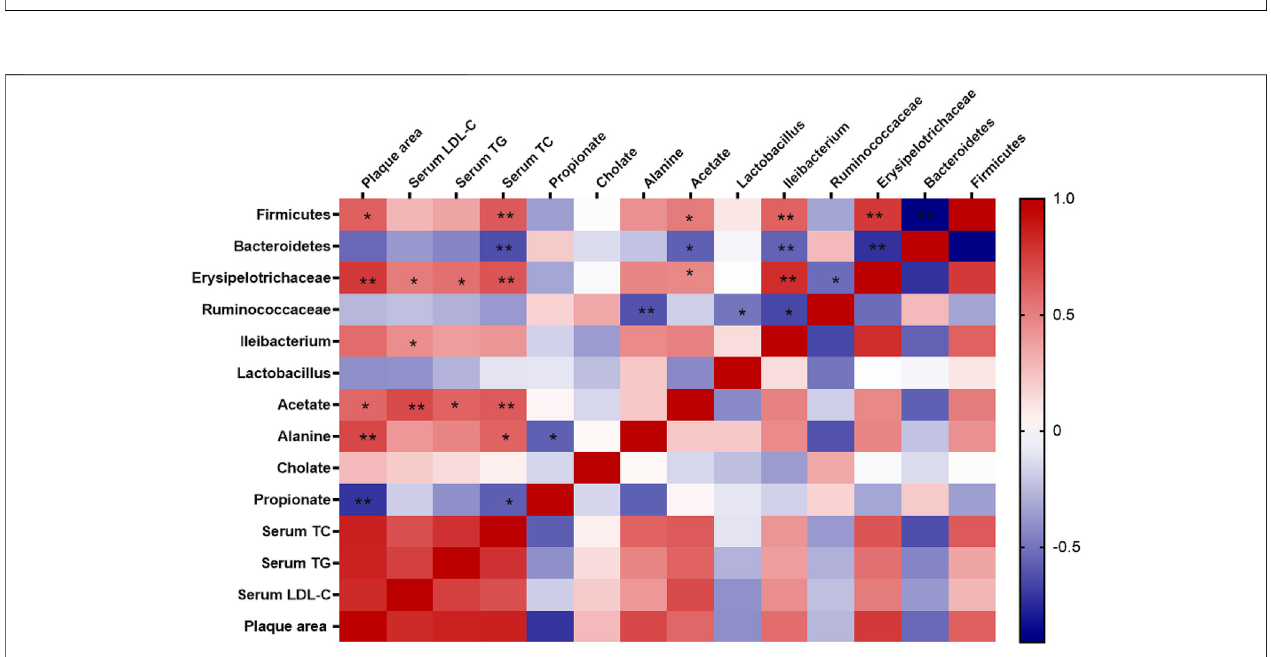
FIGURE 9 | Correlations between gut microbiota and atherosclerosis. Spearman correlation analysis (heatmap) was used to analyze the correlations between gut microbiota and physiological indices including serum levels of lipids and plaque area. The correlation analysis value was represented by colors of grids. Red stood for positive correlation and blue for negative correlation. The deeper red or blue represented higher correlation values. * p < 0.05, ** p < 0.01.